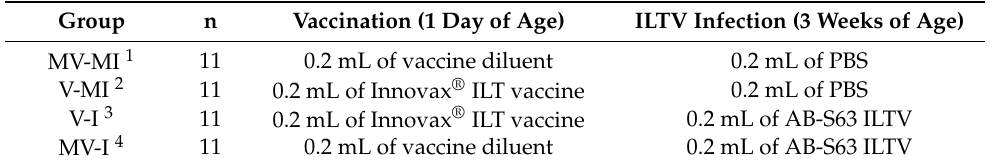
Table 1. Experimental